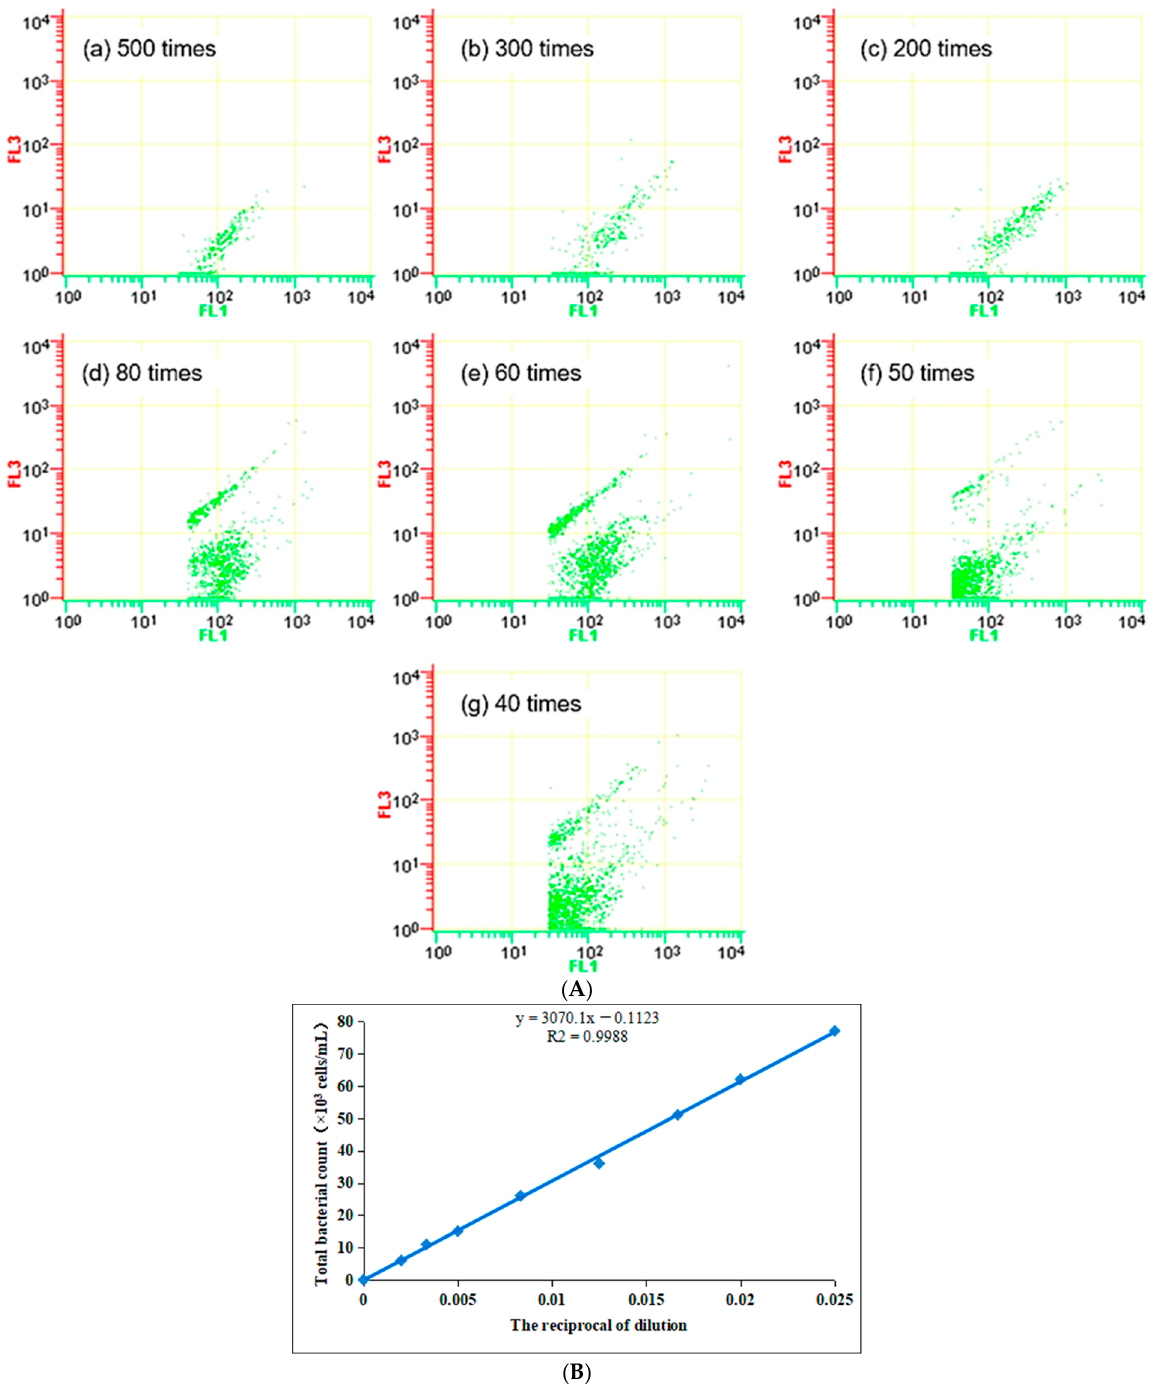
Figure 1. ( A ) The FCM of the standard bacterial suspension with different diluting multiples. ( B ) FCM-measured standard curve. ( B ) FCM-measured standard